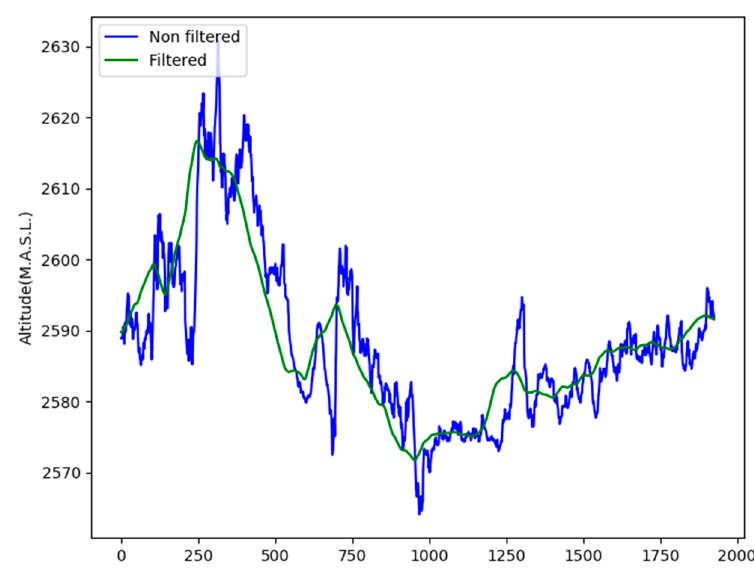
Figure 12. Filtered and non-filtered elevation profile Figure 12 . Filtered and non-filtered elevation profile vectors.